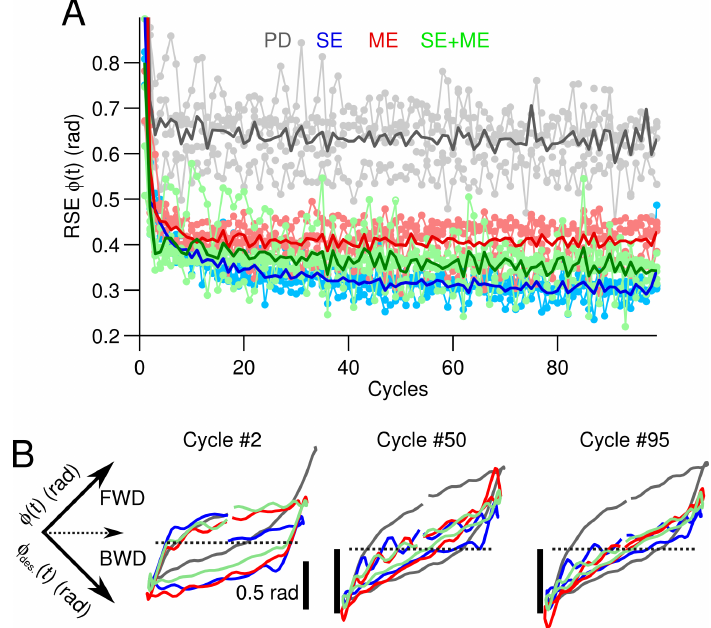
Figure 3. Performance during the control of the two-wheeled balancing robot with sinusoidal desired motion. ( A ) Control performance in terms of the root mean squared error (RSE) of φ ( t ) for the different types of climbing fiber (CF) averaged across the five experiments with different sets of initial synaptic weights. The mean value (thick line) and raw performance are shown. For reference, the performance with the proportional and derivative (PD) controller alone is shown (gray lines). ( B ) Yielded ( φ ( t ) , Y-axis) versus desired ( φ des . ( t ) , X-axis) wheel angle position (rotated − 45 degrees) when the different CFs are employed. The trajectories at Cycles #2, #50 and #95 are shown. Notation as in Figure 2. Scaled black lines mark 0.05